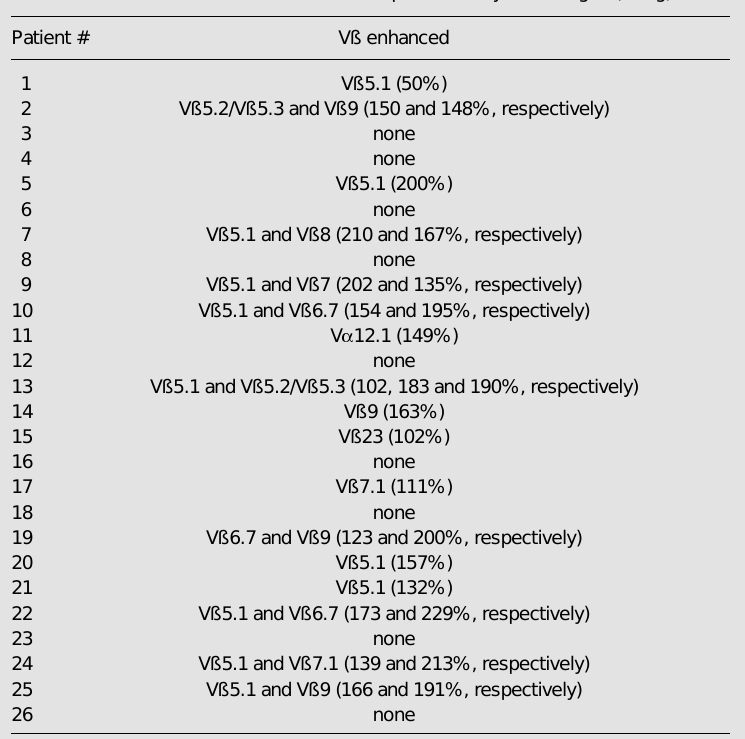
Figure 3. PBMC proliferation from six patients in response to PHA (filled line and open sym- bols), STAg (dotted line and closed symbols) and PPD (thick filled line and open symbols). Each symbol represents the pro- liferation over time of one given patient. The standard error is shown for each point. PHA-stim- ulated proliferation was meas- ured at 48 h and antigen-specific proliferation at 96 h. Proliferation data are presented as stimula- tion index (mean cpm with the stimulus divided by the cpm ob- tained in culture without the stimulus). For abbreviations, see legend to Figure